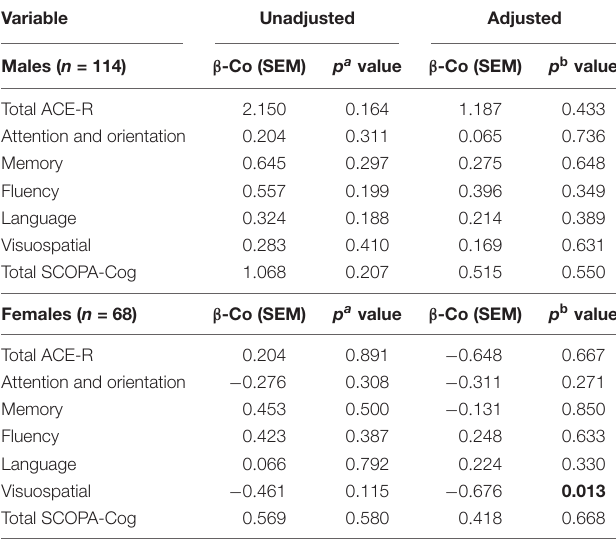
TABLE 3 | Cognitive performance in participants based on LDL levels, when separated by sex.